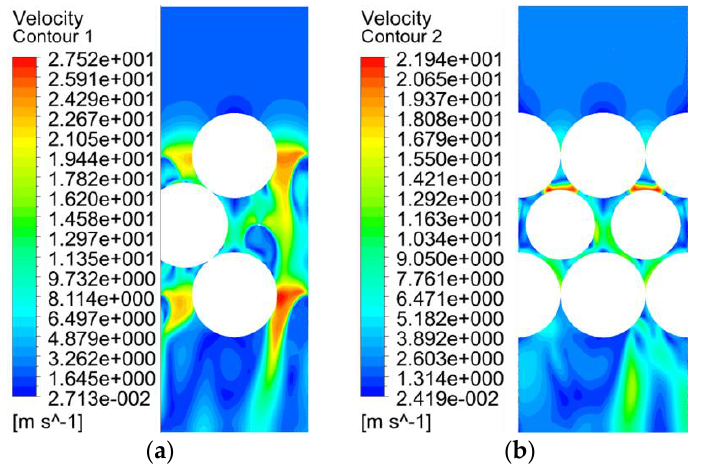
Figure 6. The velocity field of the pebble at ( a ) the middle plane and ( b ) the diagonal plane.